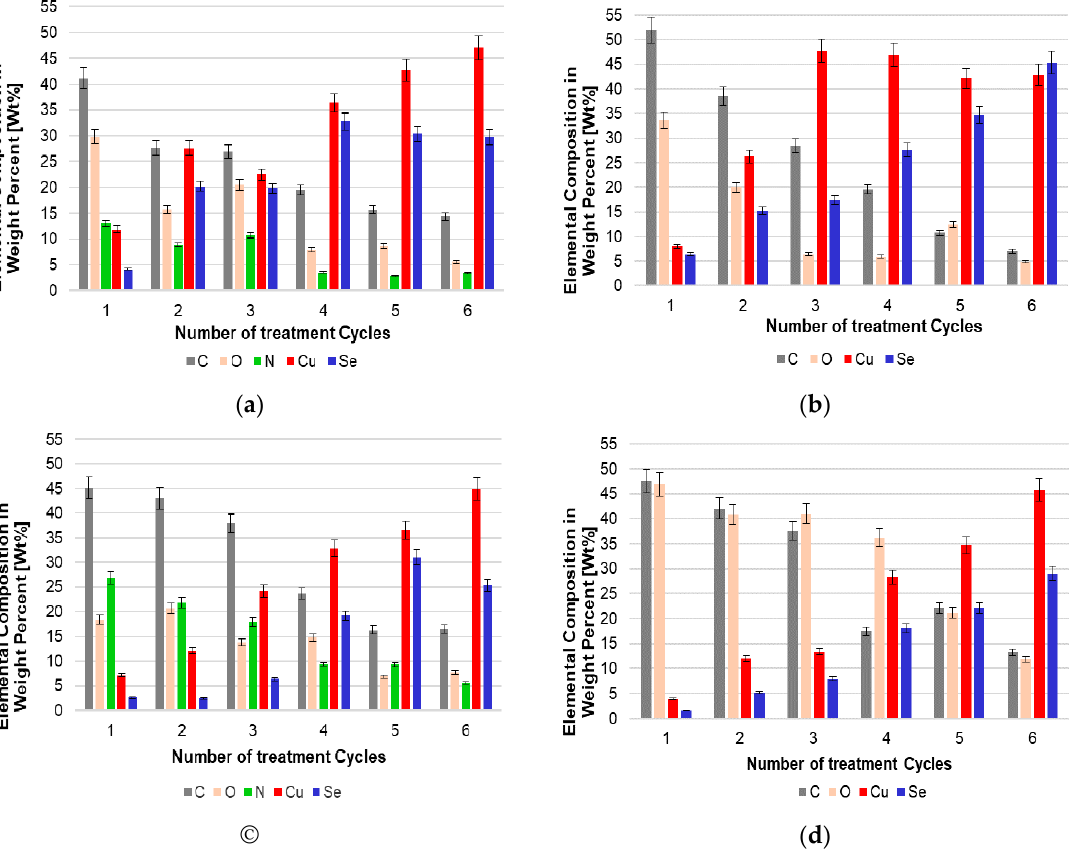
Figure 12. Surface elemental composition of the investigated treated fibers: ( a ) PA6, ( b ) PA66, ( c ) PAN, and ( d ) PES.